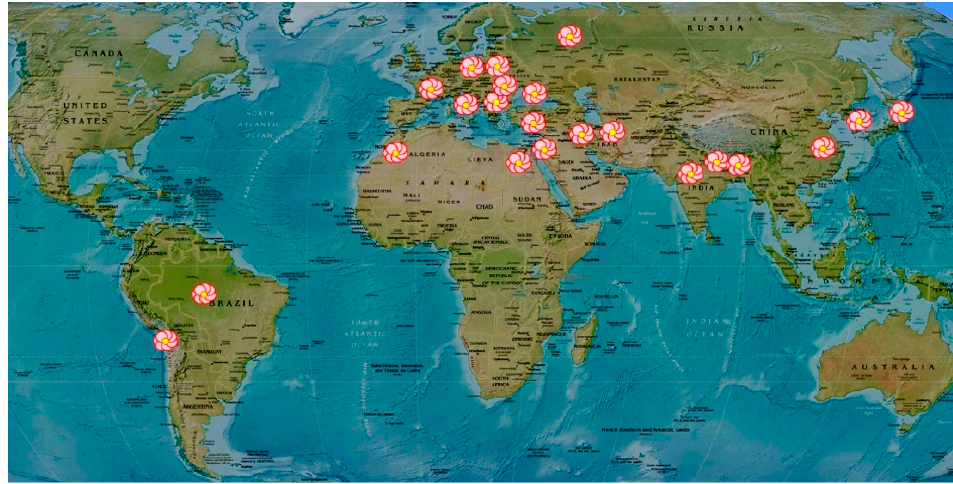
Figure 1. Main locations of rose habitats and producers of rose oils and their products worldwide.